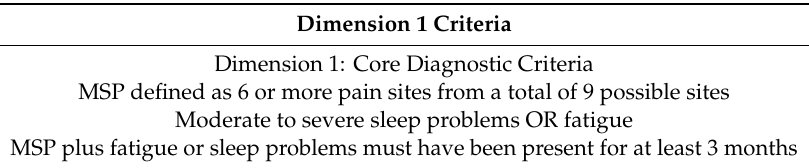
Table 1. AAPT Dimension 1 diagnostic